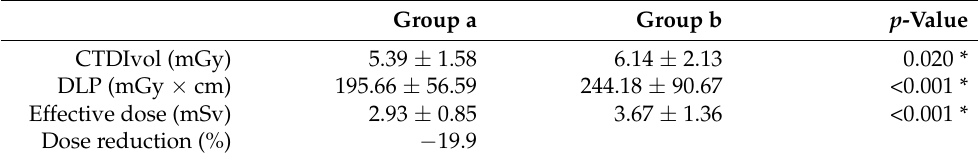
Table 6. The CTDIvol, DLP, and effective doses of Group a and Group b. Group a Group b p -Value CTDIvol (mGy) 5.39 ± 1.58 6.14 ± 2.13 DLP (mGy ×